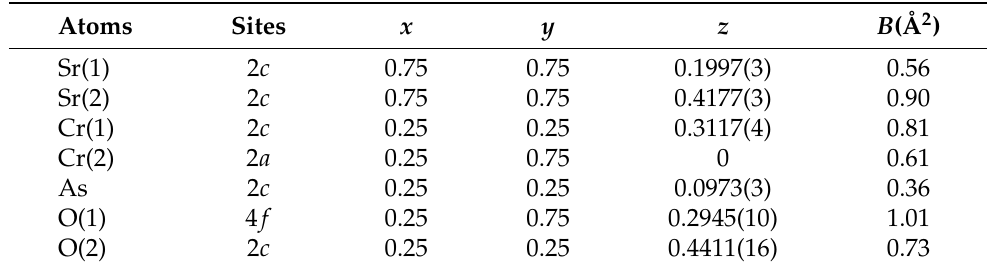
Table 2. Room-temperature crystallographic data of Sr 2 Cr 2 AsO 3 with lattice parameters of a = 3.9087(2) Å and c = 16.0481(4) Å, and with space group P 4/ nmm (No.